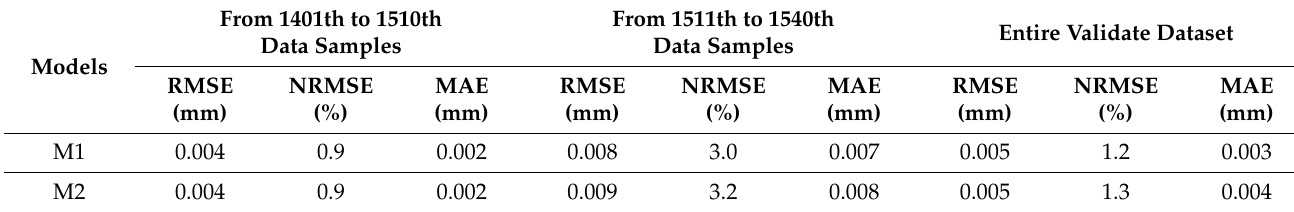
Table 6. Estimation errors of the FDE vertical vibration in validation dataset.